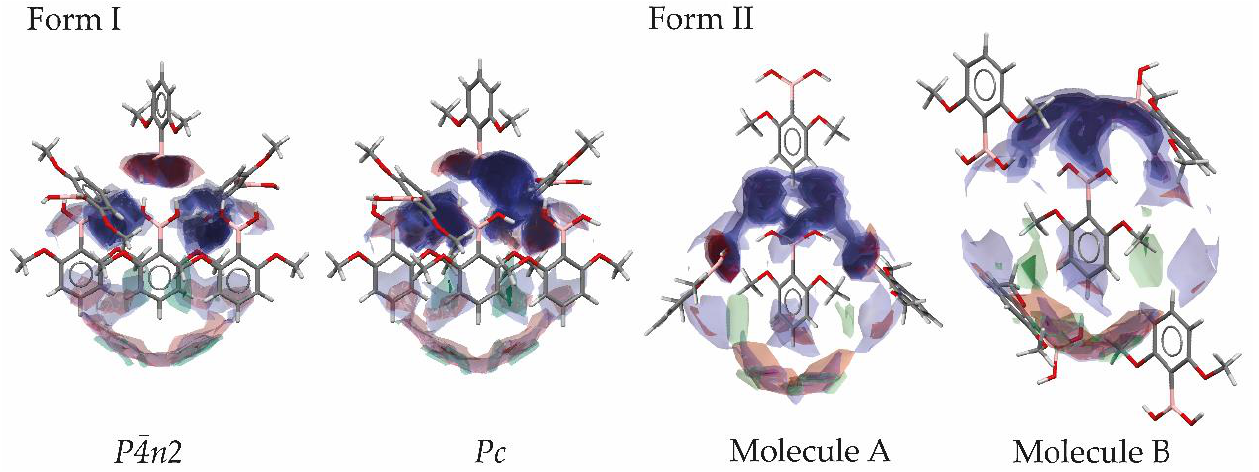
Figure 9. FIMs for MPBA polymorphs. Regions of hydrogen bond donor probability are shown in blue, hydrogen bond acceptors are shown in red, and hydrophobic interactions are shown in green.